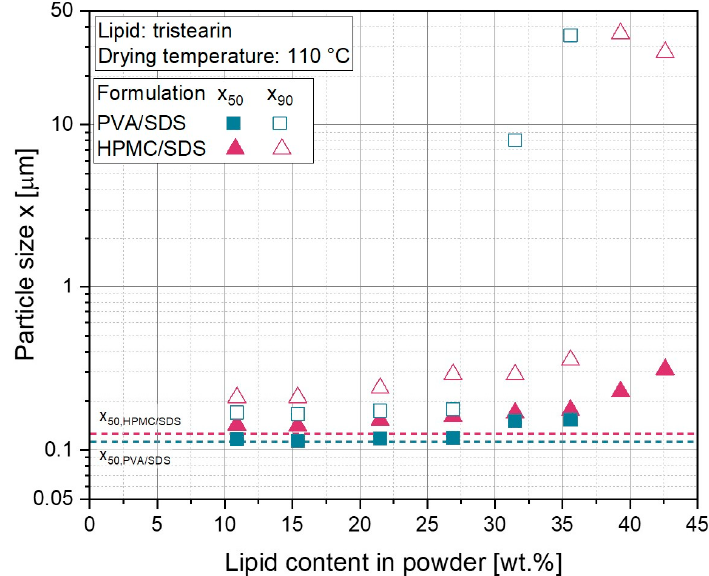
Figure 3. Particle sizes after redispersion of powders with different contents of tristearin nanoparti- cles and with two different particle stabilization systems during high-pressure homogenization: PVA/SDS and HPMC/SDS. The particle size of the original suspensions is indicated by the dashed lines.